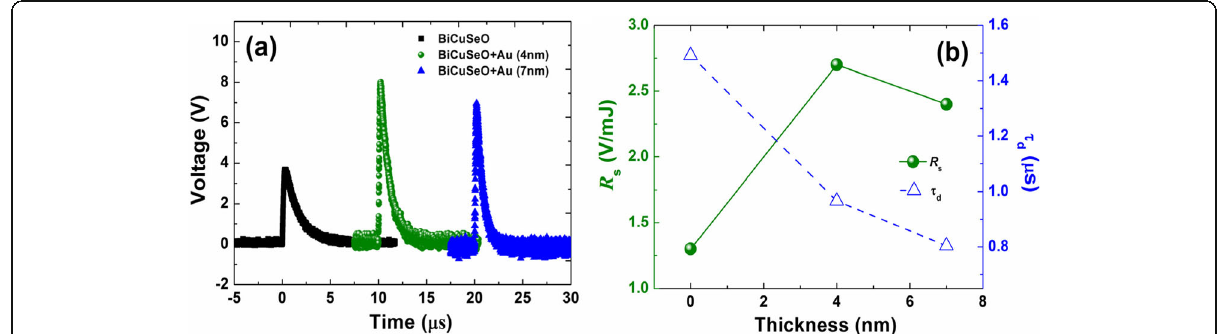
Fig. 4 a Voltage responses of bare BiCuSeO and AuNPs/BiCuSeO samples upon a 308-nm pulsed laser illumination. b Voltage sensitivity R s and decay time τ d of these